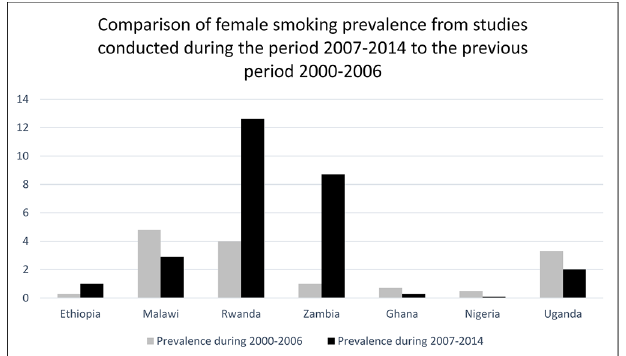
Fig 3. Reported smoking prevalence during 2000 – 2006 and 2007 – 2014 for women in 7 countries in sub-Saharan Africa that were included in the review.